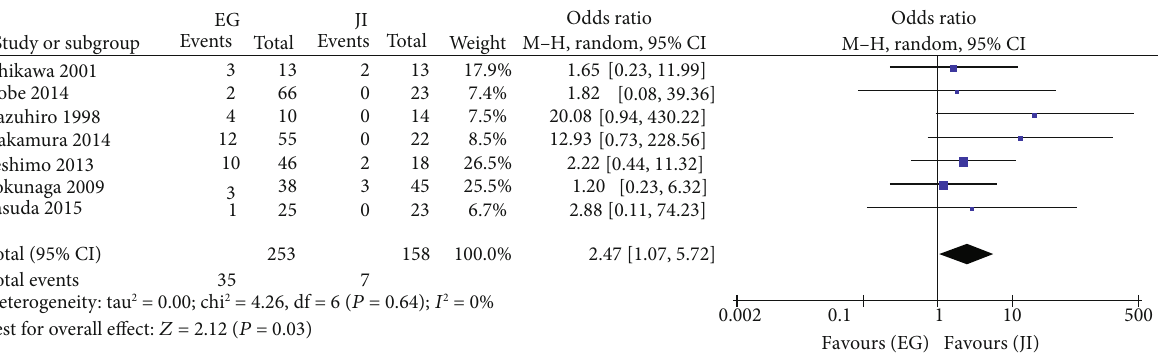
Figure 4: Meta-analysis of postoperative complications associated with EG versus JI: re fl ux